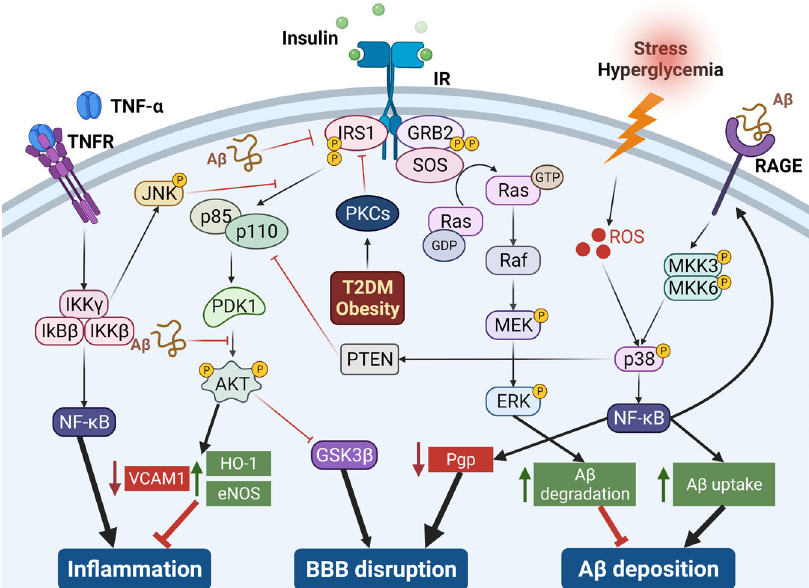
Fig. 1 Insulin signaling pathway was found to be associated with cerebrovascular pathologies in AD including in fl ammation, BBB disruption, and A β accumulation. In fl ammation: PI3K/Akt pathway mediates eNOS activation 10 which could inhibit VCAM-1 expression 11 in endothelial cells. BBB disruption: Inhibition of GSK3 β was shown to promote tight junction stability in BBB 8 and insulin enhanced the BBB integrity via PI3K/Akt/GSK3 β pathway 48 . A β accumulation: Insulin exposure promoted A β degradation via an increase in insulin-degrading enzyme (IDE) expression in astrocytes, via activation of the ERK-mediated pathway 9 . In neurons, A β exposure was shown to induce insulin resistance by inhibiting IRS1 66 , PDK-dependent Akt activation 67 , and activating p38 pathway 68 . Preliminary data from our lab suggests that A β could have a similar effect on these pathways in BBB endothelial